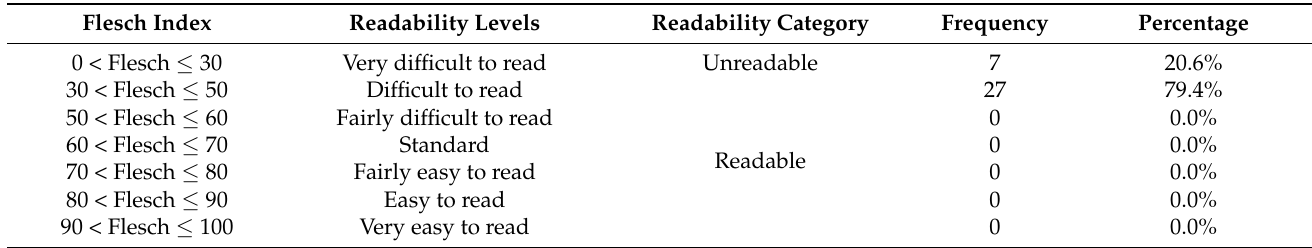
Table 6. Flesch readability